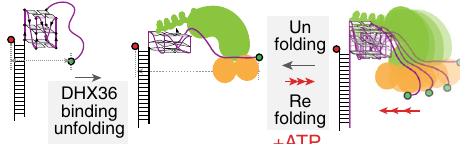
Fig. 7 Schematic summary for DHX36 activity on G4-RNA. The ATP- independent unfolding of G4-RNA is followed by ATP-dependent and repetitive refolding which generates a highly asymmetric pattern of DHX36